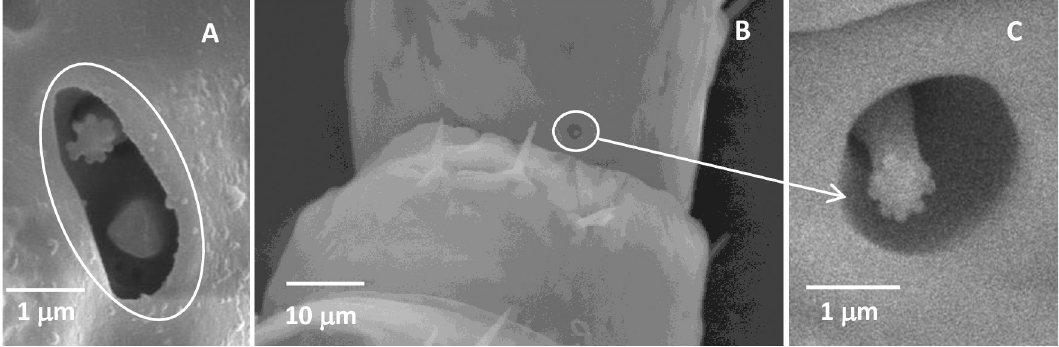
Fig 5. Cavity sensillum in the fifth-instar Diaphorina citri nymphs. (A) Cavity sensillum 1, containing an oval sensory cavity and two pegs. (B) Cavity sensillum 2, containing a round sensory cavity and one peg. (C) The high magnification picture of cavity sensillum